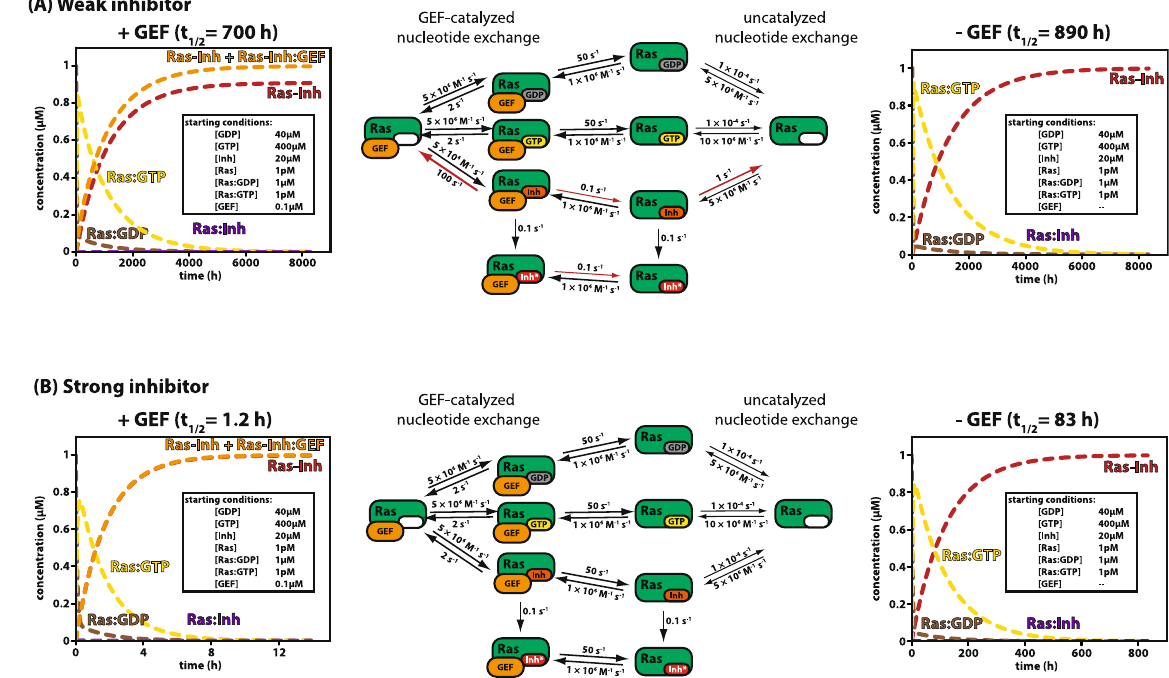
Figure 4. Simulation of covalent inhibition of KRas G12C in vivo . ( A ) The kinetic parameters obtained here and in previous publications were used to simulate the covalent inhibition of KRas G12C in vivo . Using an inhibitor with the properties of SML-8-73-1 (which is referred to as a weak inhibitor due to the low reversible affinity), the simulations led to half-lifes of covalent reaction of 890 h in the absence and 700 h in the presence of a nucleotide exchange factor. Non-covalent interactions are indicated by a colon (Rab:GDP in brown, Rab:GTP in yellow and Rab:Inhibitor in violet), covalent interactions by a hyphen (free Ras-Inhibitor in red and total concentration of Ras-Inhibitor including the fraction bound to GEF in orange). The simulation in the presence of GEF shows that a significant fraction of the covalently locked Ras-Inhibitor is bound to SOS because of the high affinity of the GEF to the Ras-Inhibitor complex. ( B ) The simulation was repeated with a (theoretical) inhibitor that retains the high affinity of binding known from GDP and GTP (and is therefore termed “strong” inhibitor). Note the dramatic decrease of half-lifes of the covalent reaction both in the absence (83 h) and especially in the presence (1.2 h) of a nucleotide exchange factor compared to the situation with the weak inhibitor (simulation files are available on request and can be opened with KinTek Explorer (http://kintekcorp.